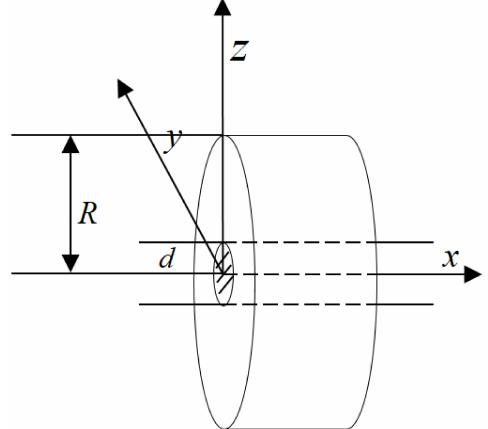
Figure 1. Sketch of the domain of heat